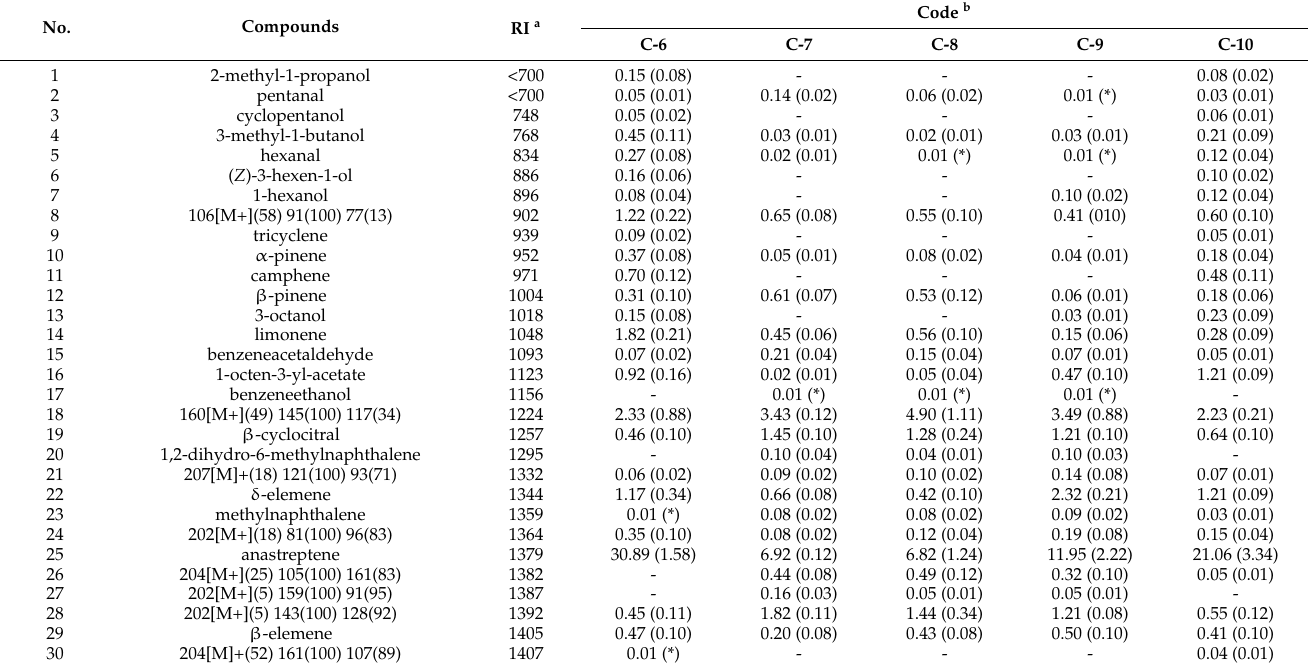
Table 3. Volatile compounds detected in the samples